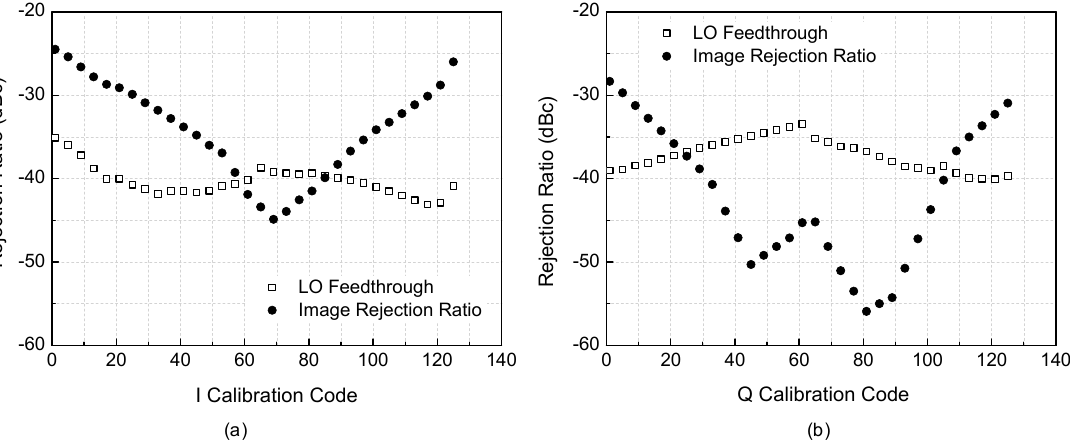
Figure 13. Calibration performance of IRR and LOFT with respect to ( a ) Q-calibration code and ( b ) I-calibration code. Table 1. Performance summary and